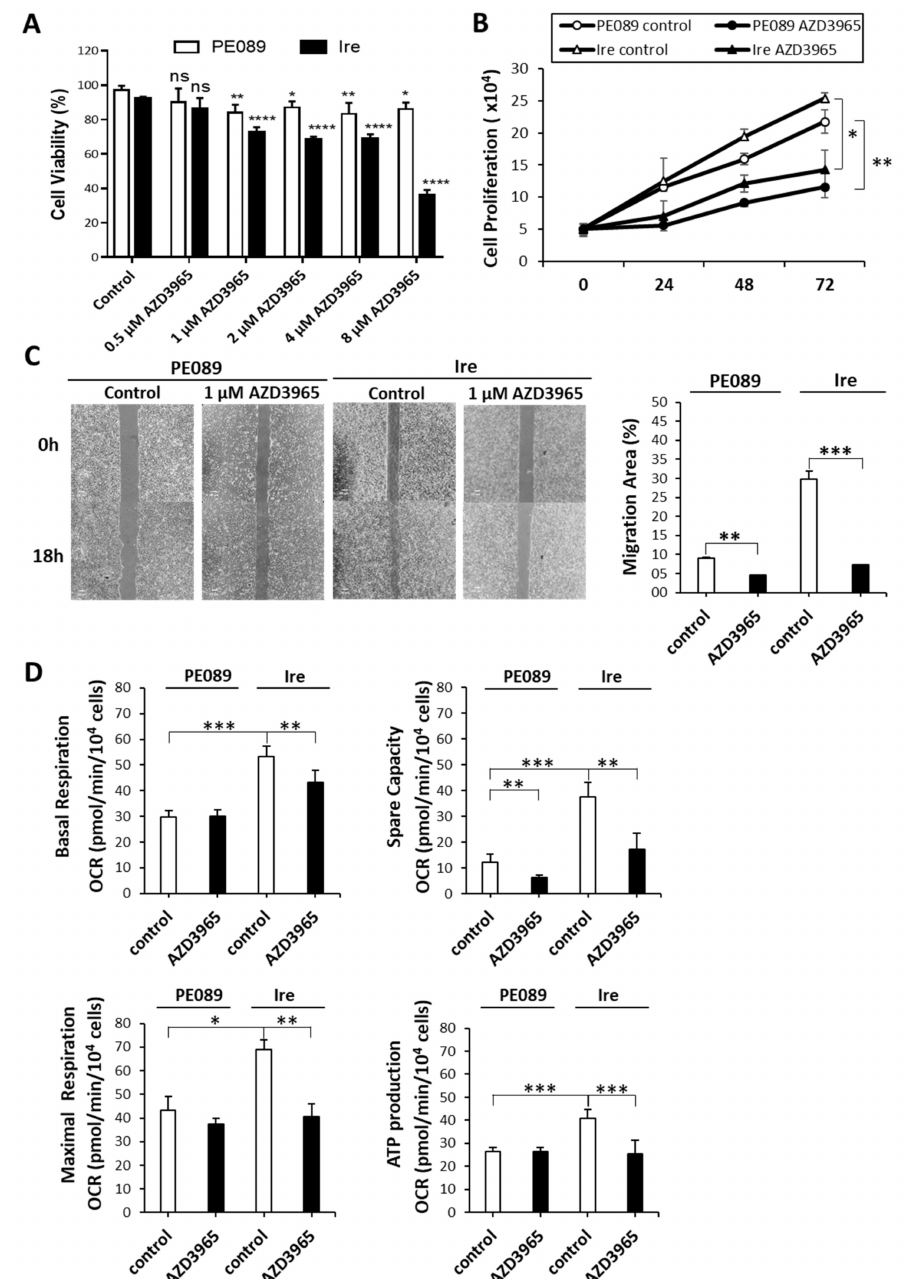
Figure 7. AZD3965 exhibited inhibitory e ff ects on the cell growth and mitochondrial bioenergetics of Ire cells. ( A ) Dose-dependent cell viability assay. Reduction in cell viability was assessed in PE089 cells and Ire cells after di ff erent concentrations of AZD3965 in 2% FBS medium. The star signs